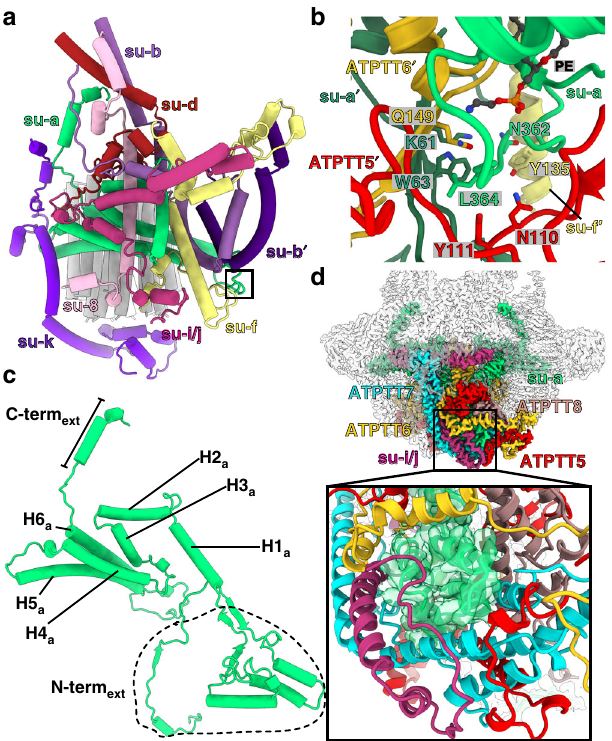
Fig. 4 Subunit- a interactions throughout the F o -subcomplex. a Subunit- a canonical six-helical core surrounded by the conserved subunits b, d, f, i/j, k and 8. It forms a non-canonical interaction with subunit- b ′ . The c-ring is grey. Window corresponds to the region shown in b close-up view.